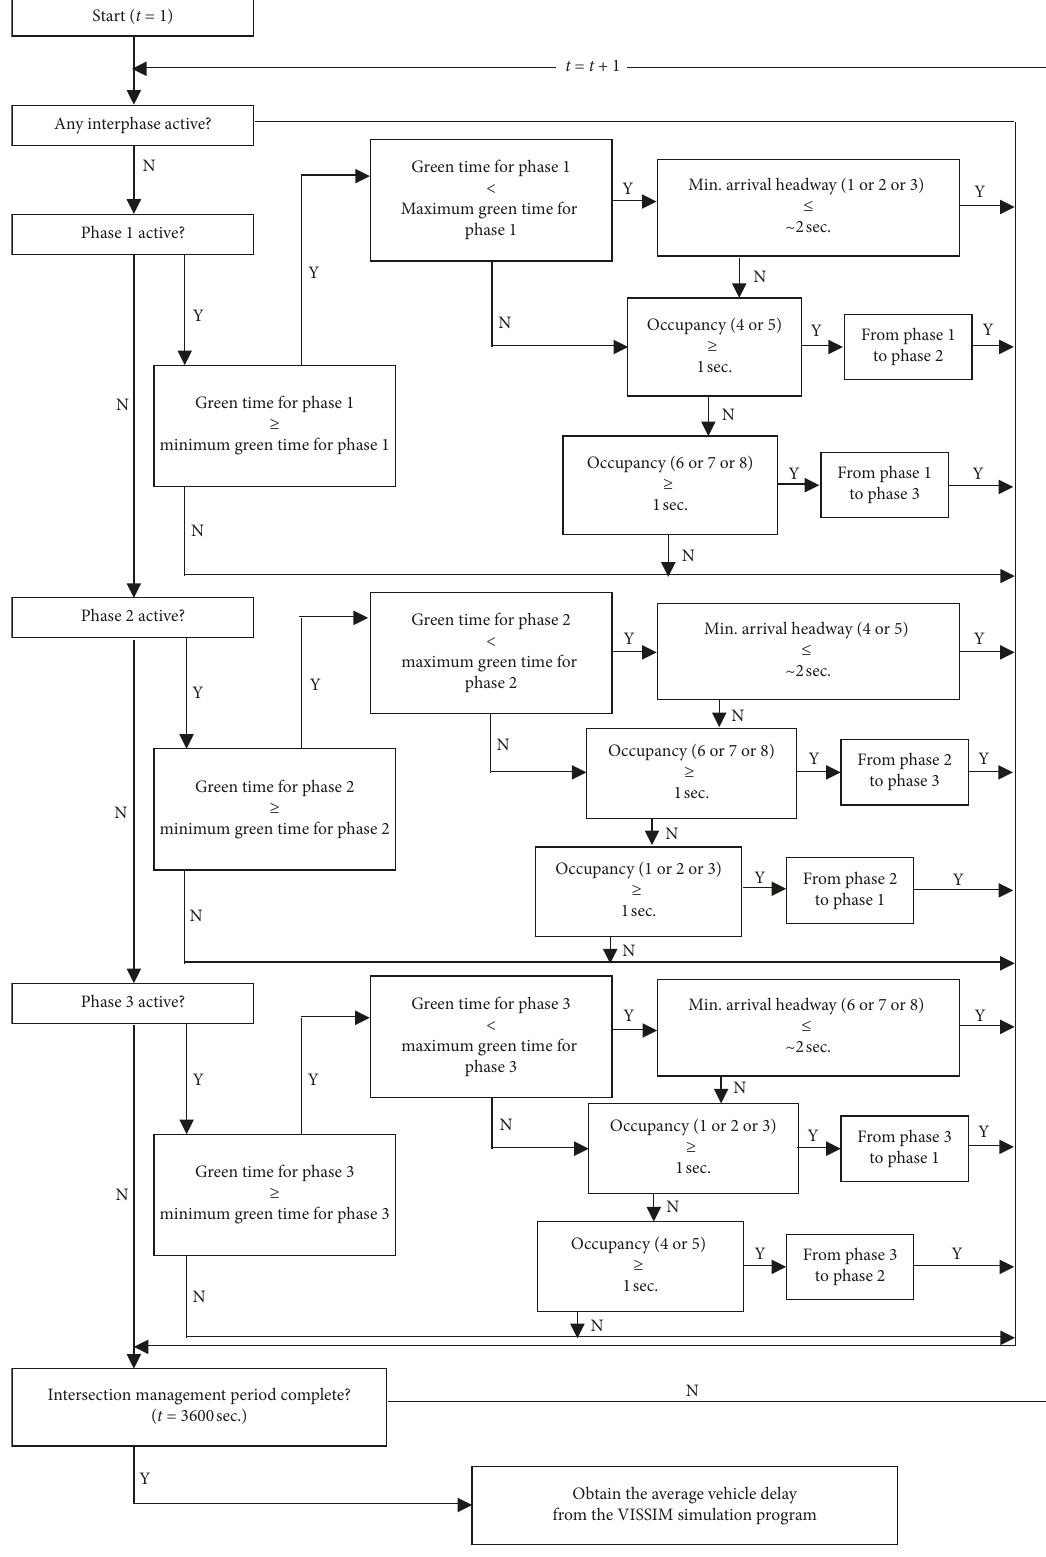
Figure 7: Flowchart of the vehicle-actuated management algorithm created with VAP